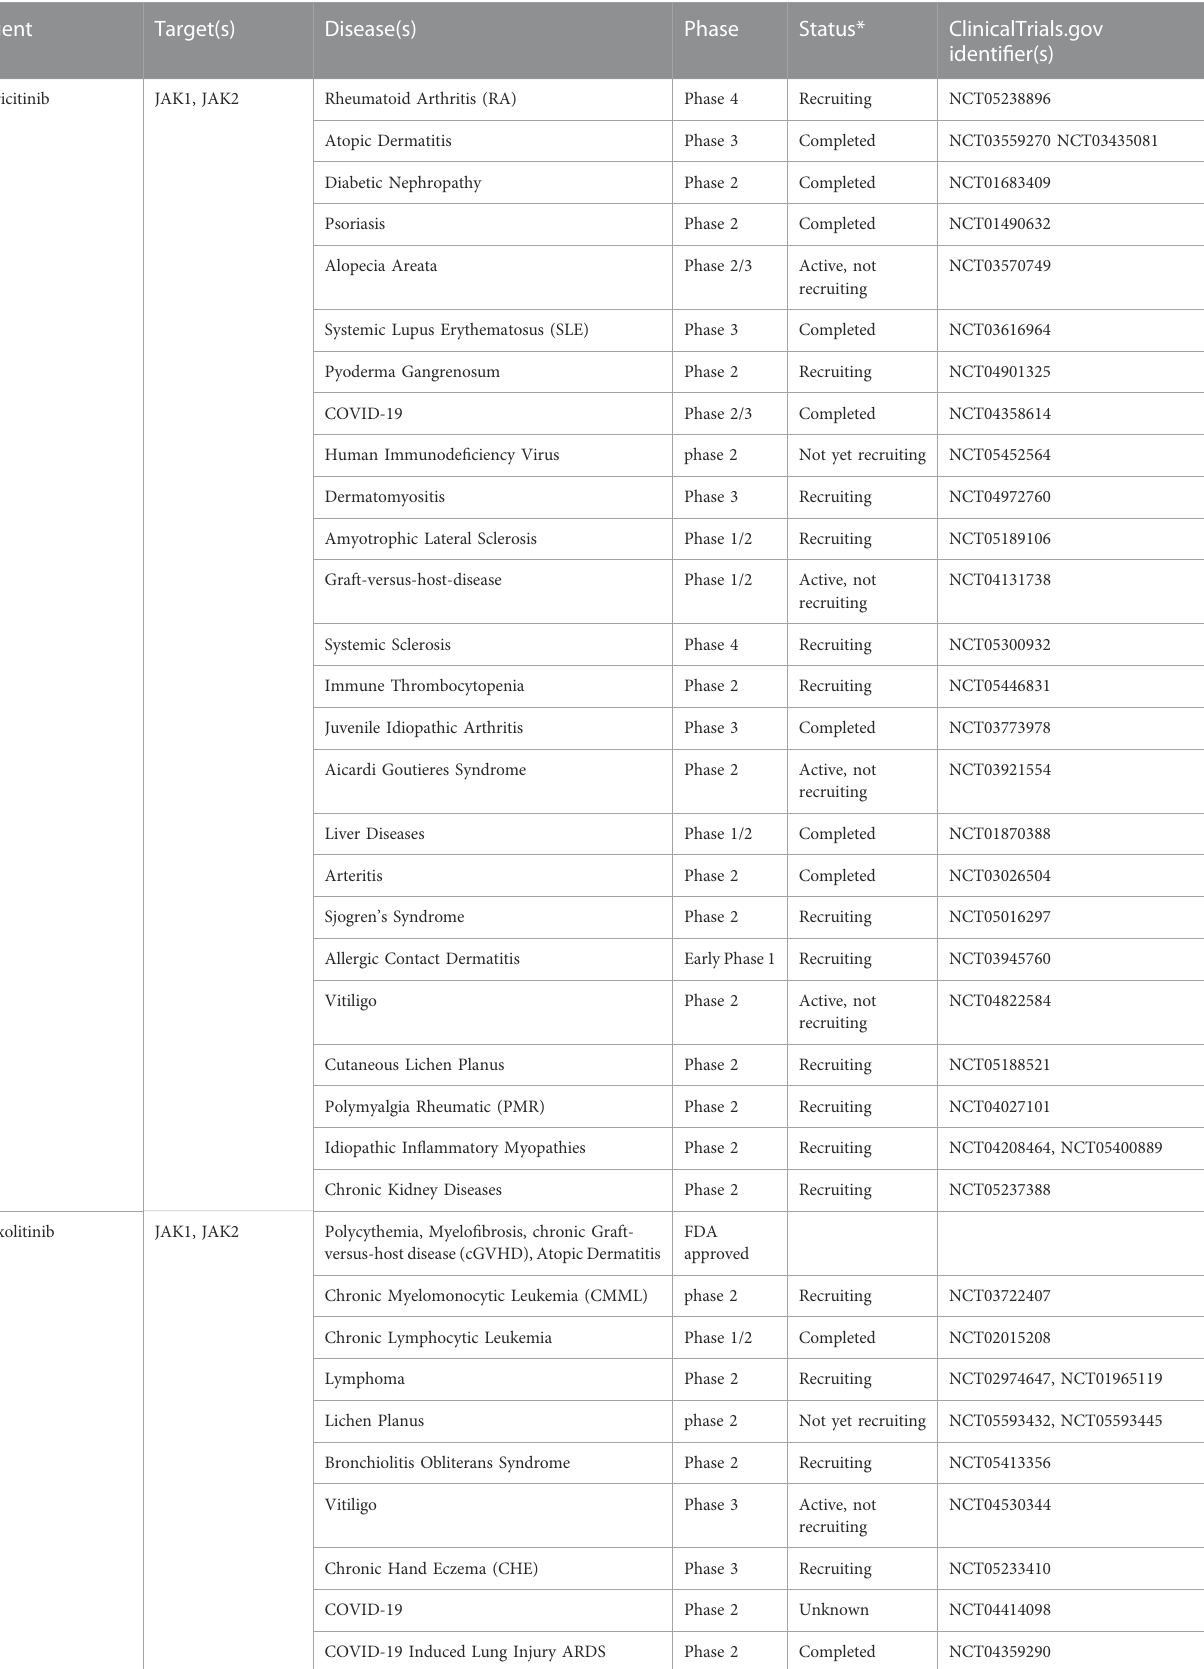
TABLE 2 Clinical study of JAK/STAT